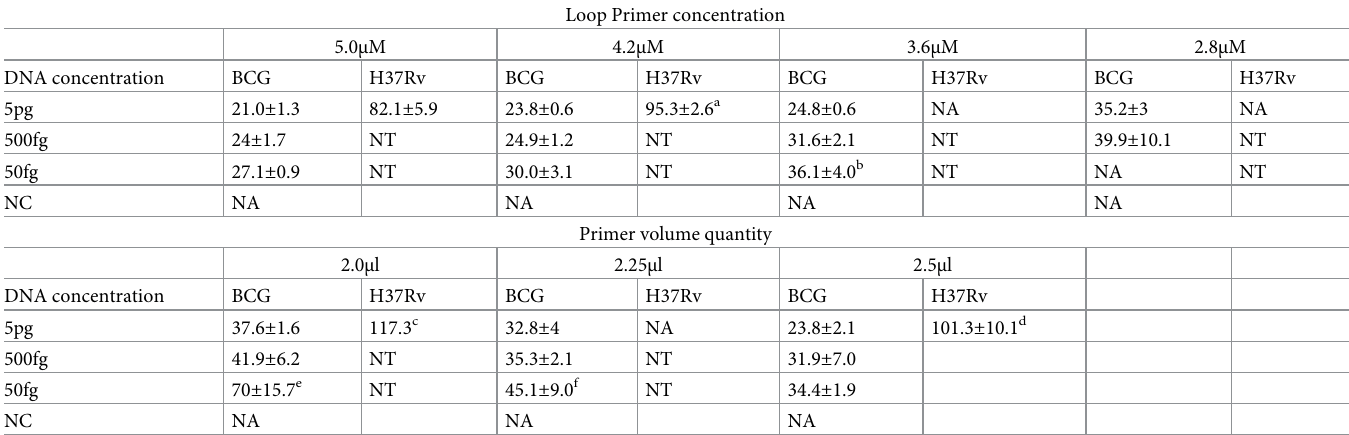
Table 3. Optimization of primer concentrations and ratios in LAMP